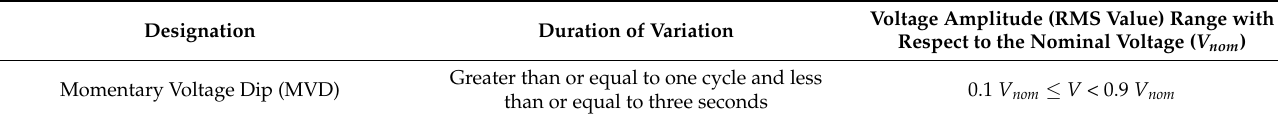
Table 1. Voltage ranges applied to the SDVV